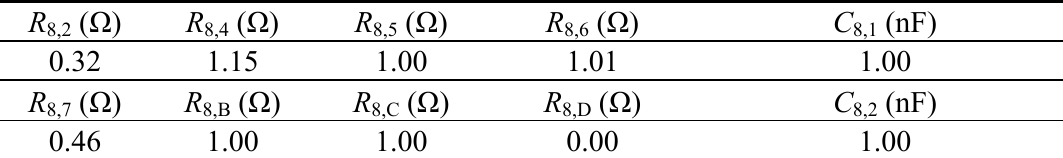
Table 4. Component values (corresponding to factor 8—Friend’s circuit).